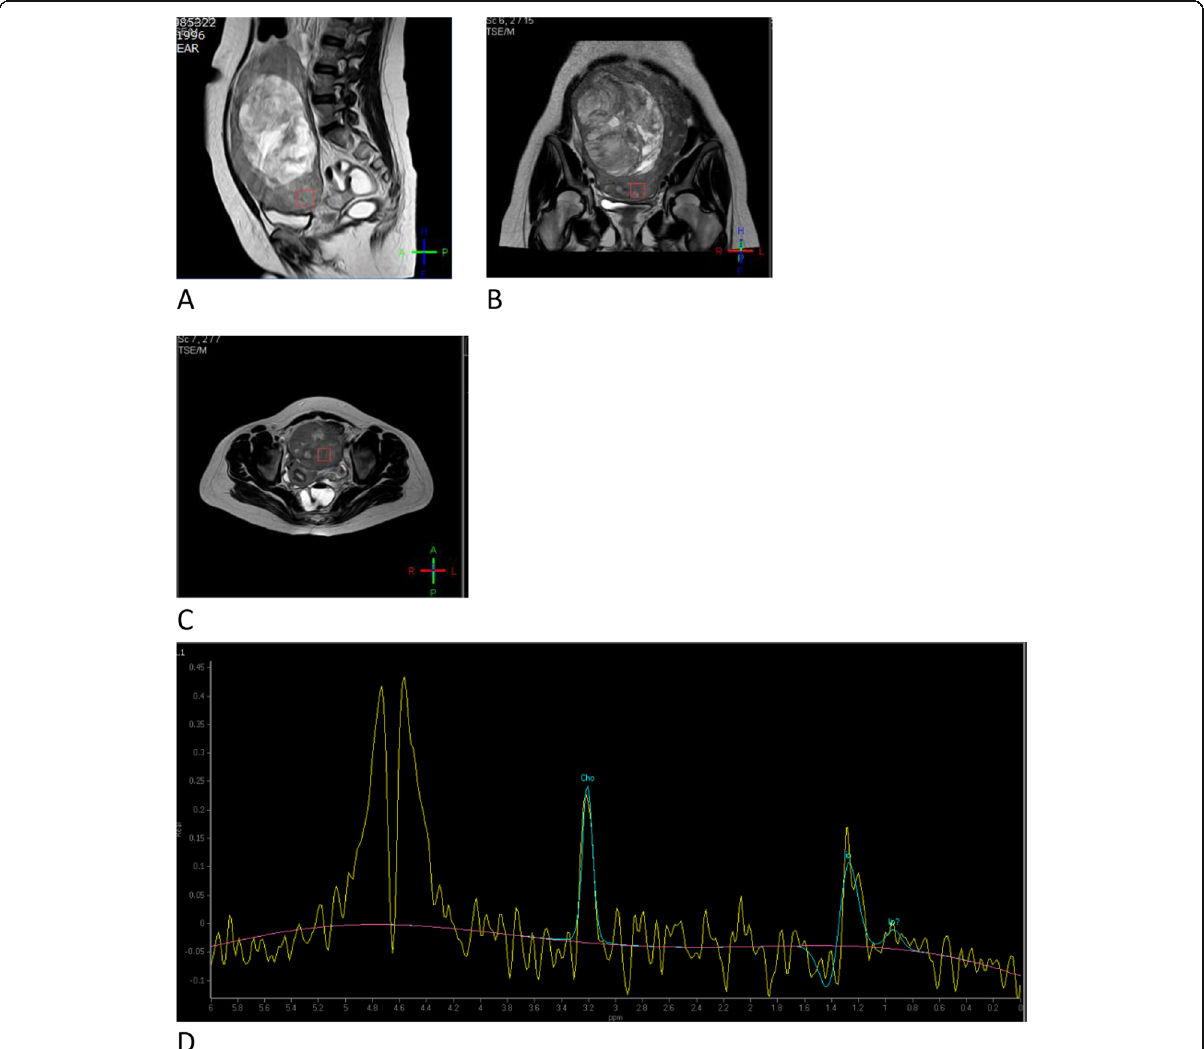
Fig. 4 A 22-year-old patient with pathologically proven mixed germ cell tumor of the left ovary. a – c Sagittal, coronal, and axial T2-weighted images respectively with voxel in the solid part of the mass. d MR spectroscopy shows sharp choline peak with Cho/Cr ratio 8.3. Also seen lipid peak at 1.3